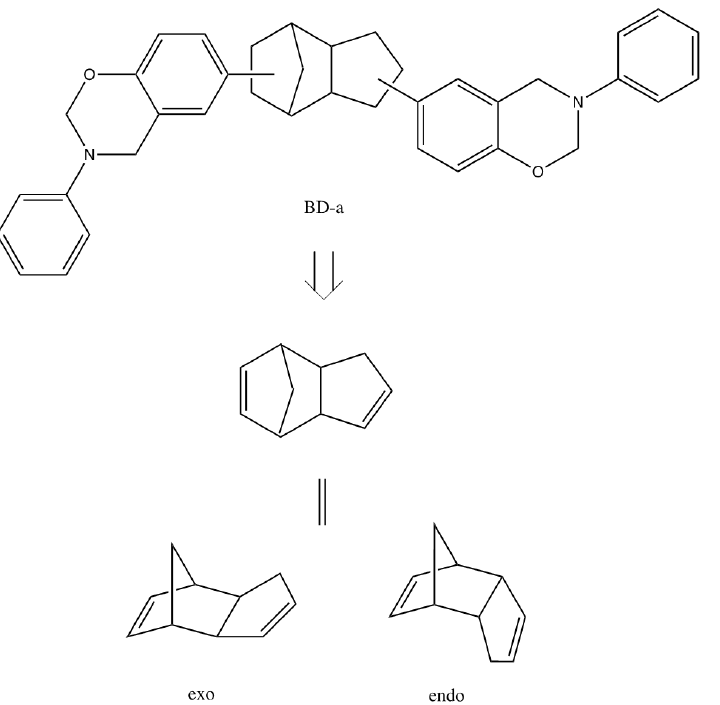
Figure 9. Structure of BD-a monomer, ultimately derived from dicyclopentadiene (showing exo and endo